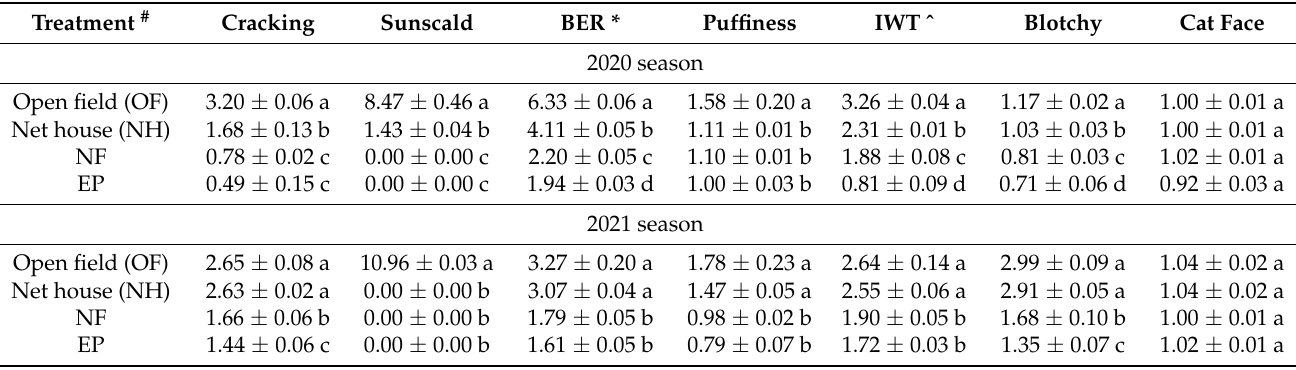
Table 3. Effect of modified walk-in tunnels compared to open field on common fruit disorders of tomato (as a percentage of total yield).